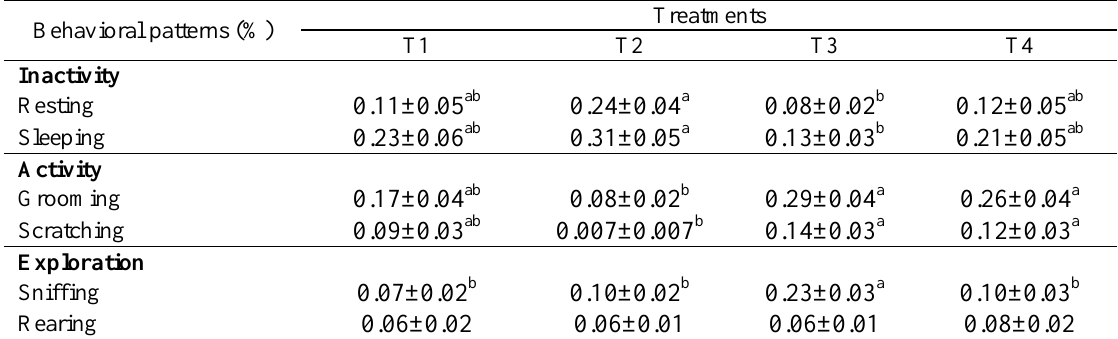
Table 2: The impact of aqueous extract of Eruca sativa leaves on the behavioural responses (%) of healthy and thioacetamide intoxicated mice (mean ±